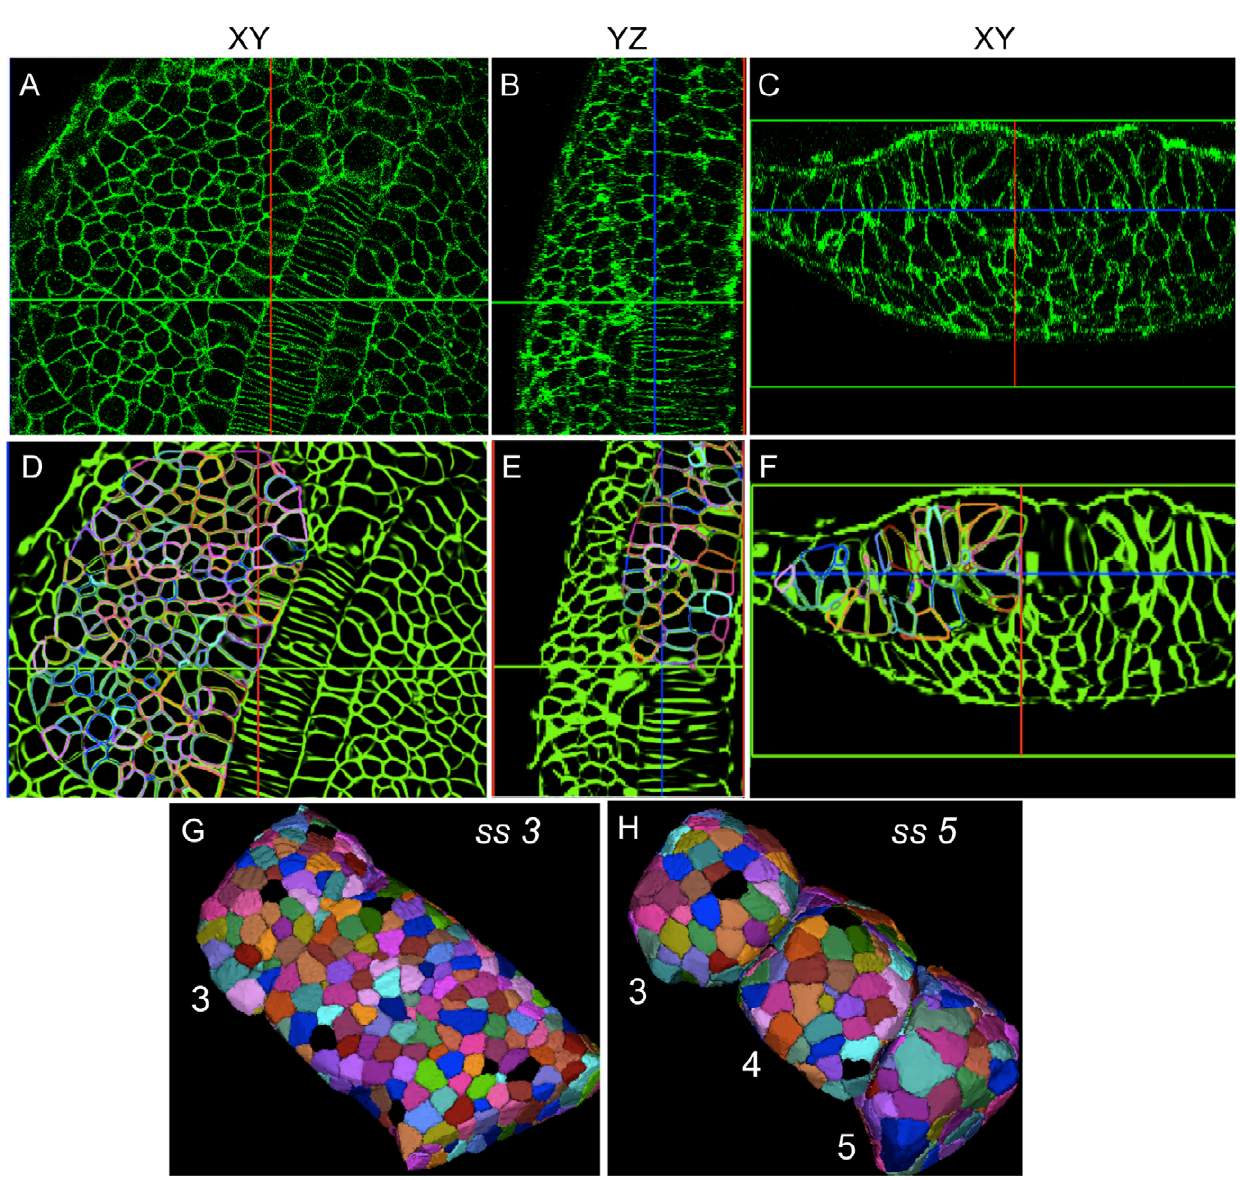
Figure 5. Robust reconstruction and segmentation of cells in the presomitic mesoderm. (A–C) Raw image data showing presomitic mesoderm on 2D image planes (XY,YZ, and XZ) at 3ss. (D–F) Segmentation meshes overlaid on reconstructed membrane images demonstrate excellent localization. Each mesh was randomly colored for visually separating adjacent cells easily. (G,H) 3D rendering of membrane segmentations at 3ss and 5ss. Somites 3, 4 and 5 at 5ss are formed from the presomitic tissue at 3ss by cell sorting and